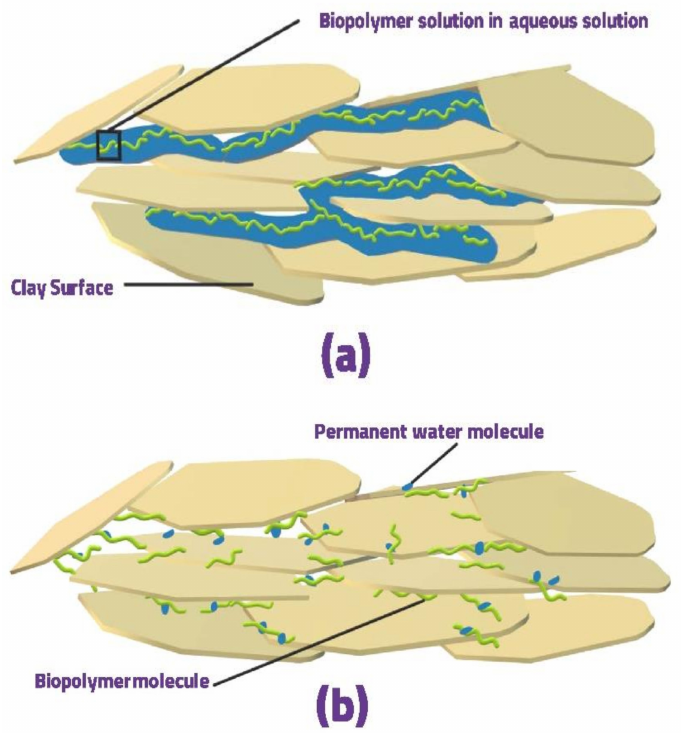
Figure 12. Moisture effect in interaction of biopolymer with clay sheets ( a ) moist biotreated sample, ( b ) dried biotreated sample